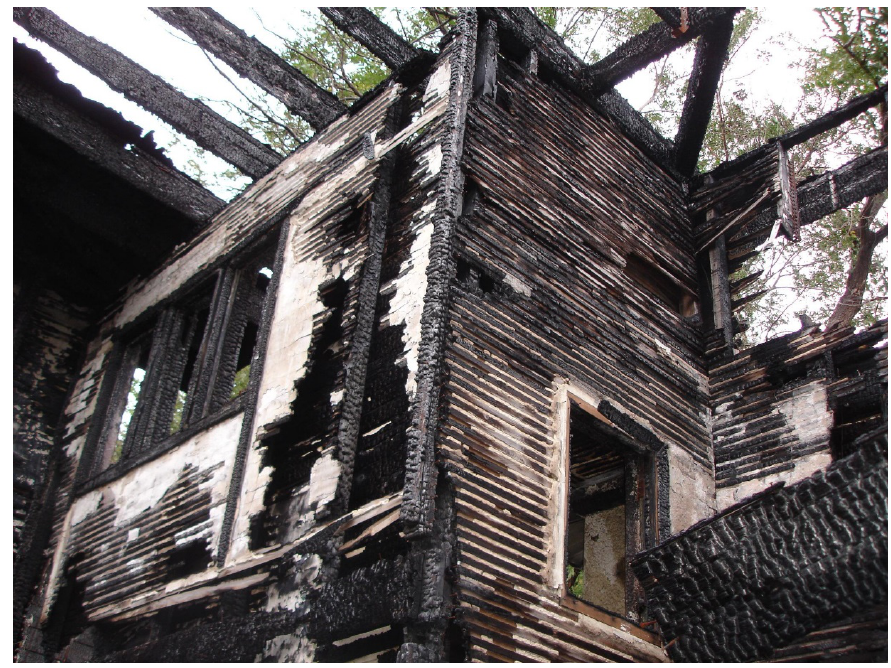
Figure 3. Single-Family Home designed by architect, Frank Lloyd Wright, Gary, Indiana House has been demolished (Photo courtesy of Ball State University Graduate architecture student Mickel